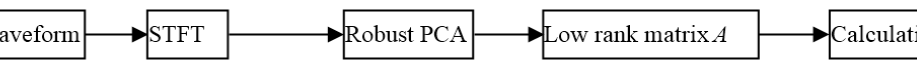
Figure 3. Calculation of enhanced PCP (EPCP).